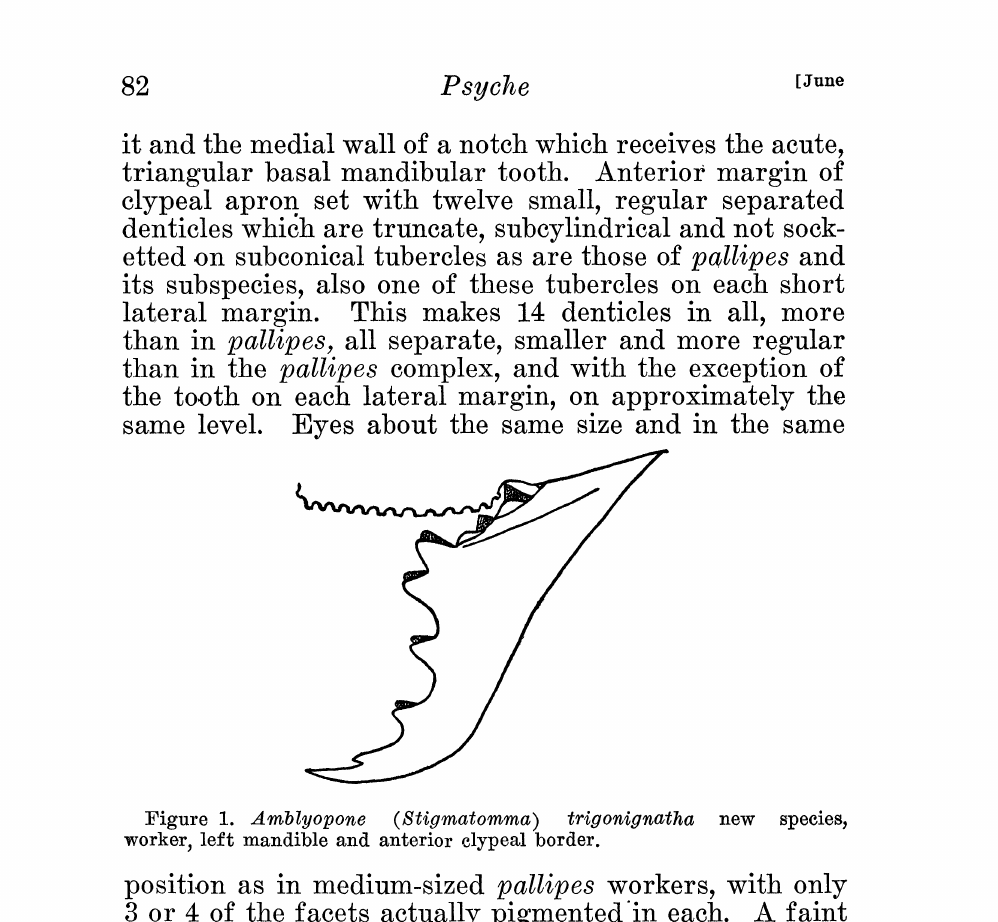
Figure 1. Amblyopone (Stigmatomma) trigonignatha new species, worker, left mandible and anterior clypeal border. position as in medium-sized pallipes workers, with only 3 or 4 of the facets actually pigmentedin